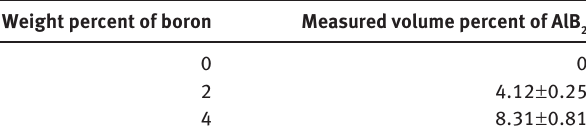
Table 2 Measured amount of reinforcing particles as a function of the level of boron added to the Al-Cu